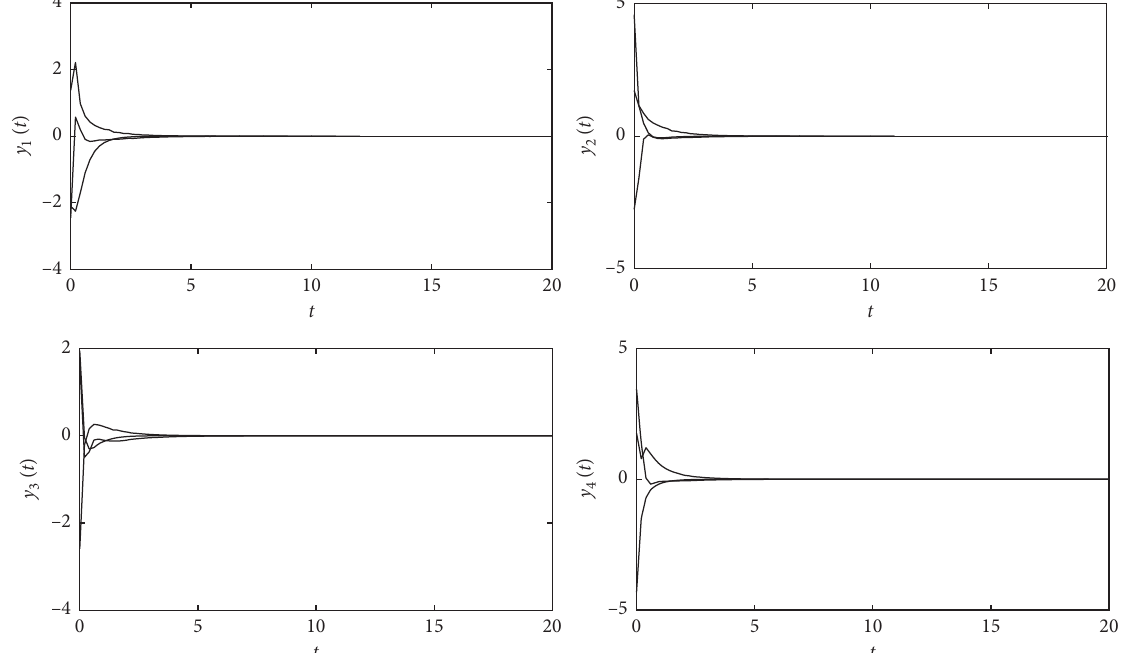
( t ) ( i ∈ [ 1 : 4 ] ) approach 0. i